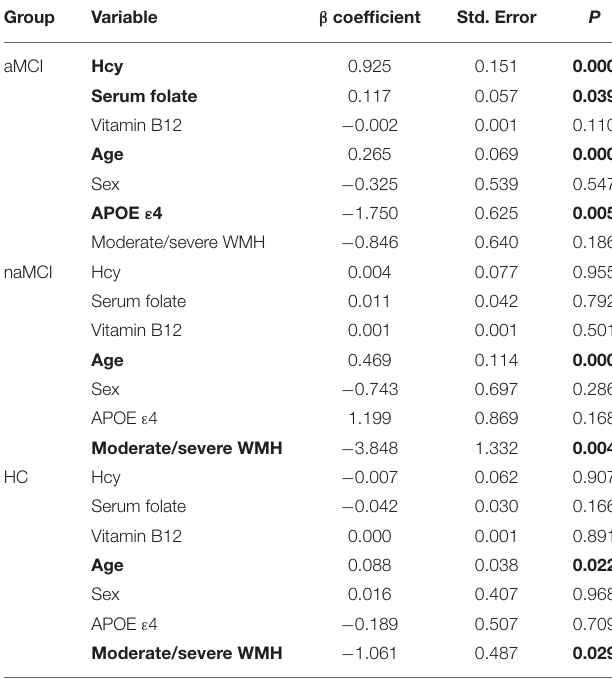
TABLE 4 | Comparison of MTA, WMH, and APOE4 across MCI and control groups.